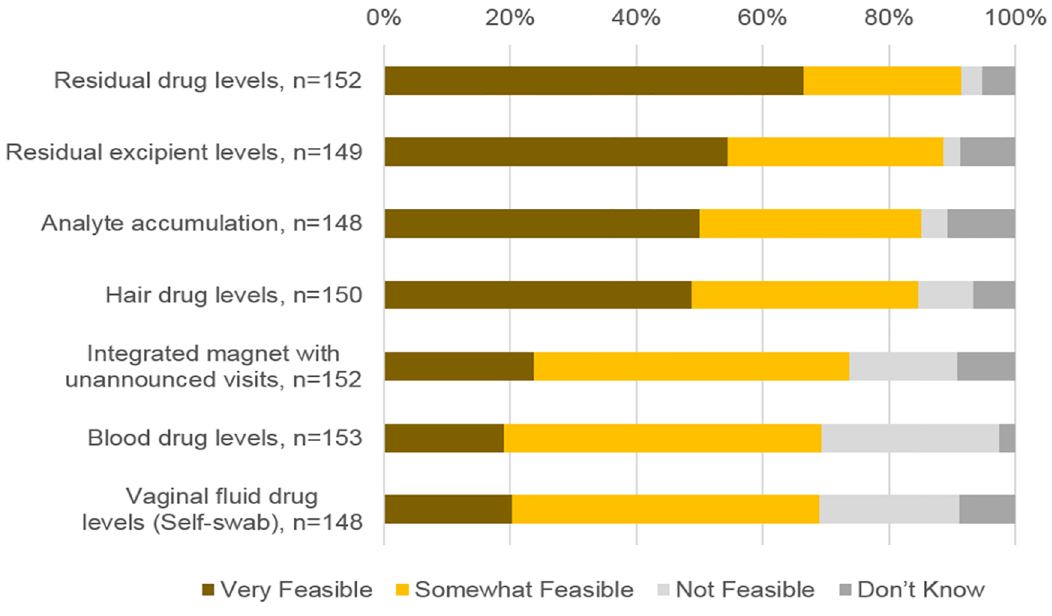
Fig 2. Respondents’ views on feasibility of implementing measuresin clinical